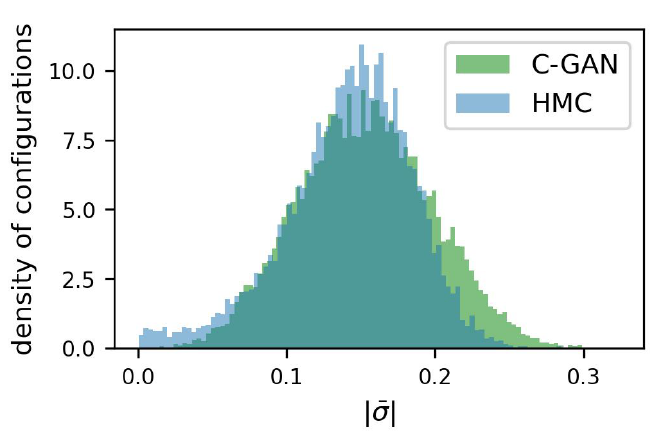
Figure 14: Histogram of | ¯ σ | at λ = 1.5 ∈ Λ ts quite well.